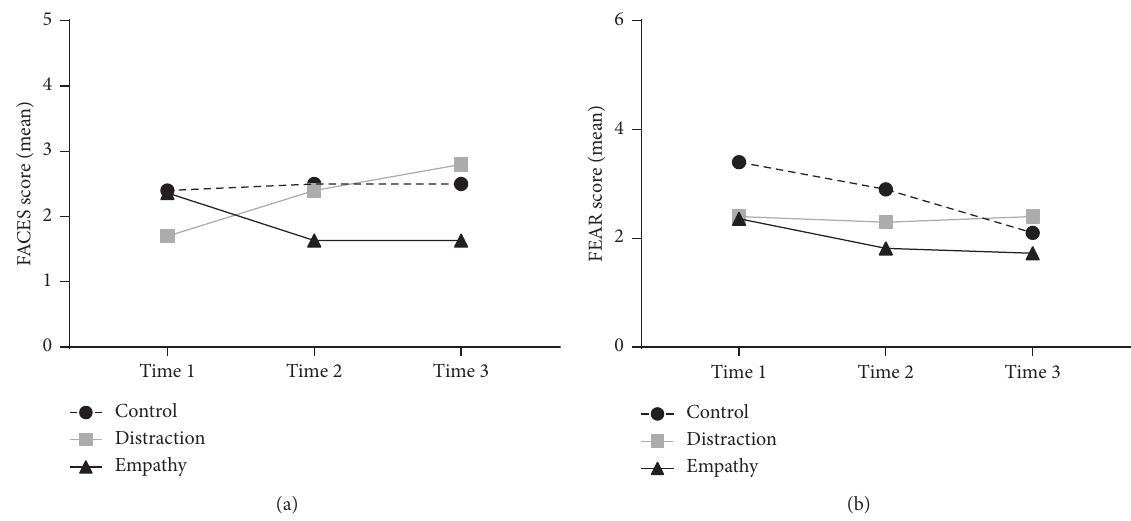
Figure 3: Patient-reported pain and distress scores over time. (a) Mean scores on the FACES scale showing decrease (less pain) over time in the empathy group. (b) Mean scores on the FEAR scale also showing decrease (less distress) over time in the empathy